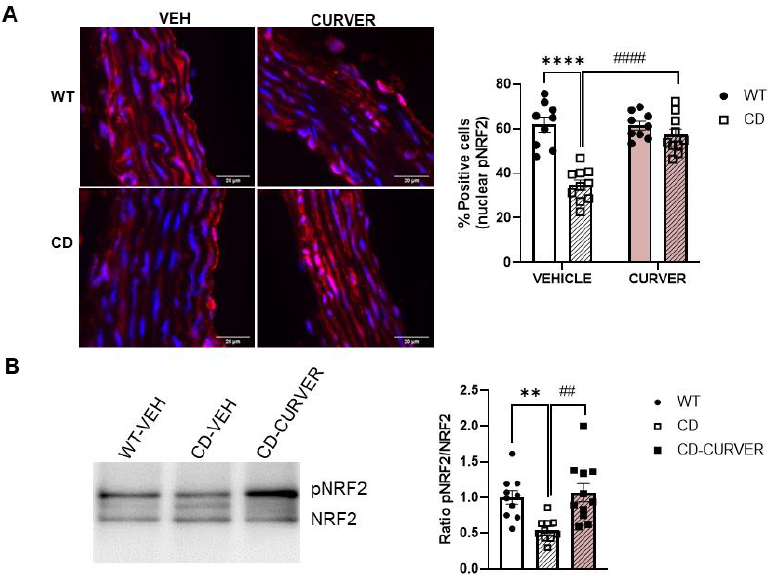
Figure 5. CURVER therapy increases pNRF2 nuclear location in the cardiovascular system of CD mice. ( A ) Immunohistofluorescence was performed to detect the pNRF2 protein in VSMCs of the tunica media (red) and nuclear staining (DAPI, blue) (Left panel). A significant genotype/treatment interaction could be observed (F (1, 34) = 19.30; p = 0.0001). Two-way ANOVA with Tukey’s multiple comparisons test. ( B ) Western blot (representative image, left) showed a significant reduction in pNRF2 protein levels in lysates of CD LV-myocardium compared with WT mice ( p = 0.0084). After CURVER treatment, CD mice showed similar amounts of pNRF2 with respect to WT mice ( p = 0.8771). One-way ANOVA, followed by Tukey’s post hoc comparisons. Data are represented as mean ± SEM. * Effect of genotype; #, effect of treatment. **, ## p < 0.005; ****, #### p < 0.0001 .